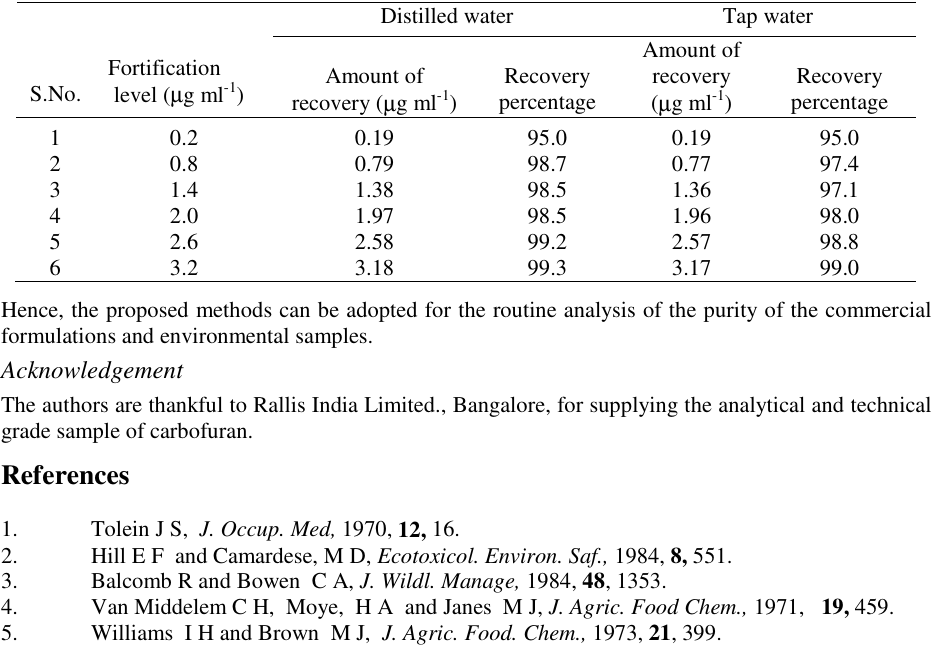
Table 7. Recovery of carbofuran from fortified water sample using diazotized 4-aminobenzaldehyde as a coupling agent.